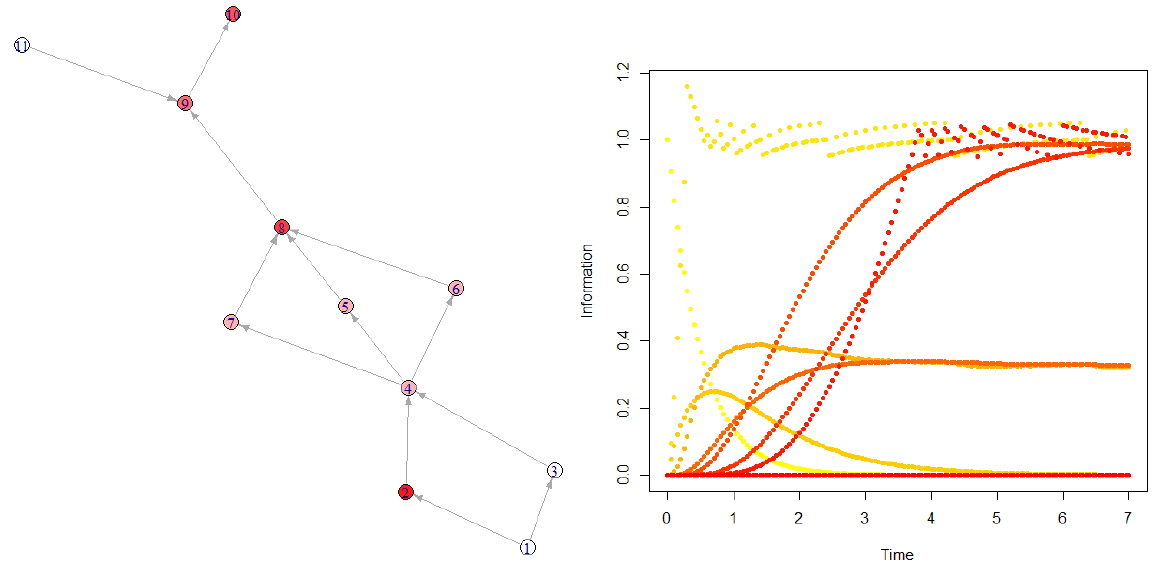
Figure 12. The information diffuses from node 1 ( f ( 0,1 ) = 1 while f ( 0, x ) = 0 for any x (cid:54) = 1) to node 10 with additional creation (to node 2) and destruction (to node 10) added. Here D = 1.